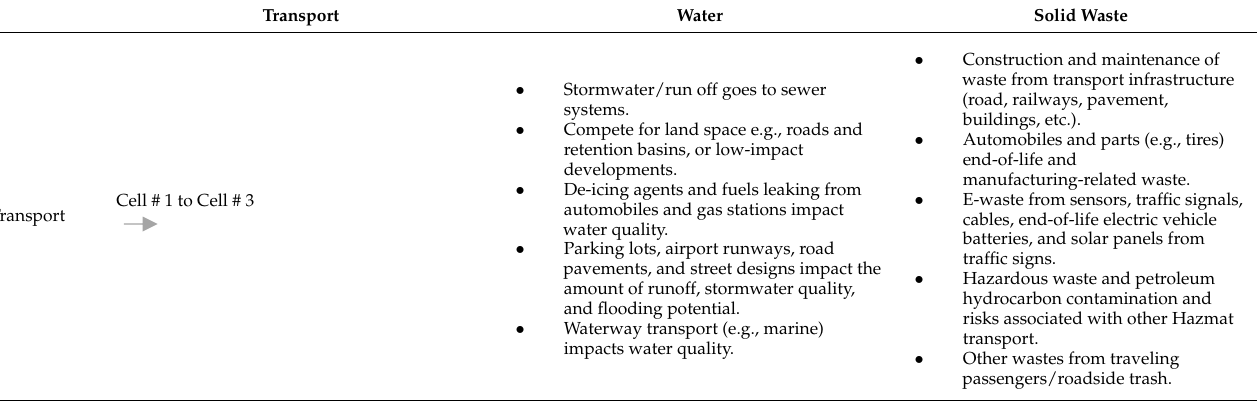
Figure 1. Schematic diagram of the interdependencies between transport, water, and solid waste infrastructure systems. Table 2. Interdependency matrix of transport, water, and solid waste infrastructure systems.